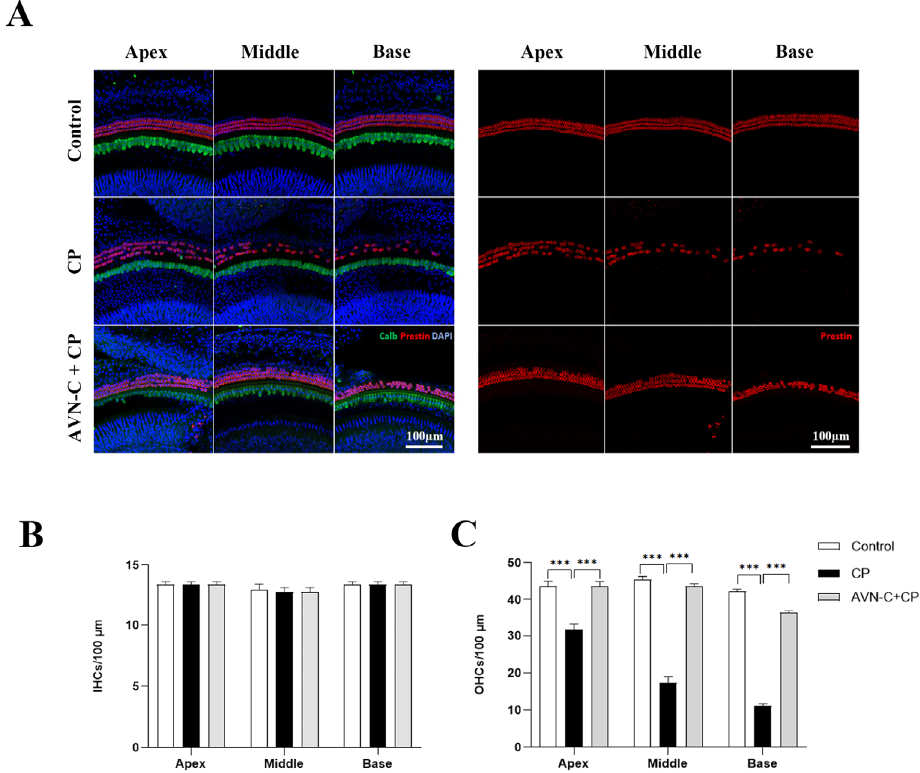
Figure 2. Immunohistochemical staining of the organ of Corti. ( A ) Right panel: images of OHCs stained with Prestin (red); left panel: combined image of Calbindin (green) for IHCs, Prestin for OHCs, and DAPI (blue) staining. ( B ) The IHCs remained unchanged in all three groups (n = 5 each). ( C ) The OHCs were damaged severely by CP treatment (32 ± 3.4, 17 ± 3.4, and 11 ± 1.4 OHCs per 100 µm at apex, middle, and base turns, respectively) whereas AVN-C protected OHCs from the CP-induced loss (44 ± 1.5, 44 ± 1.7, and 36 ± 2.9 OHCs per 100 µm at the apex, middle, and base turns, respectively). The OHCs in the control group were found at the apex (45 ± 3.0), middle, (44 ± 2.1), and base turns (42 ± 1.5 OHCs) per 100 µm, respectively. (*** p ≤ 0.001, p ≤ 0.05 was considered significant in all experimental